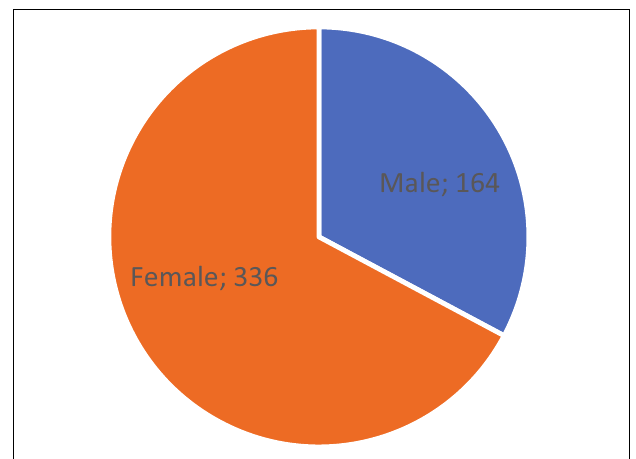
FIGURE 1 | Gender. Source : Own processing.